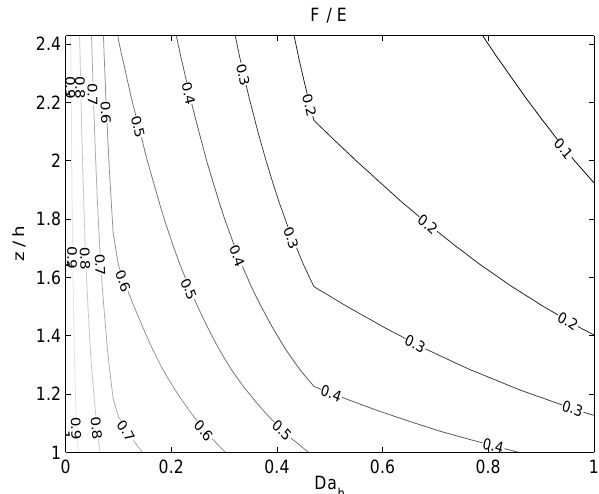
Fig. 6. Flux-to-surface-exchange ( F / E ) ratio as a function of canopy-top Damk¨ohler number and ratio of measurement height ( z ) to the canopy height ( h ). This is a visualization of the look-up table (Supplementary